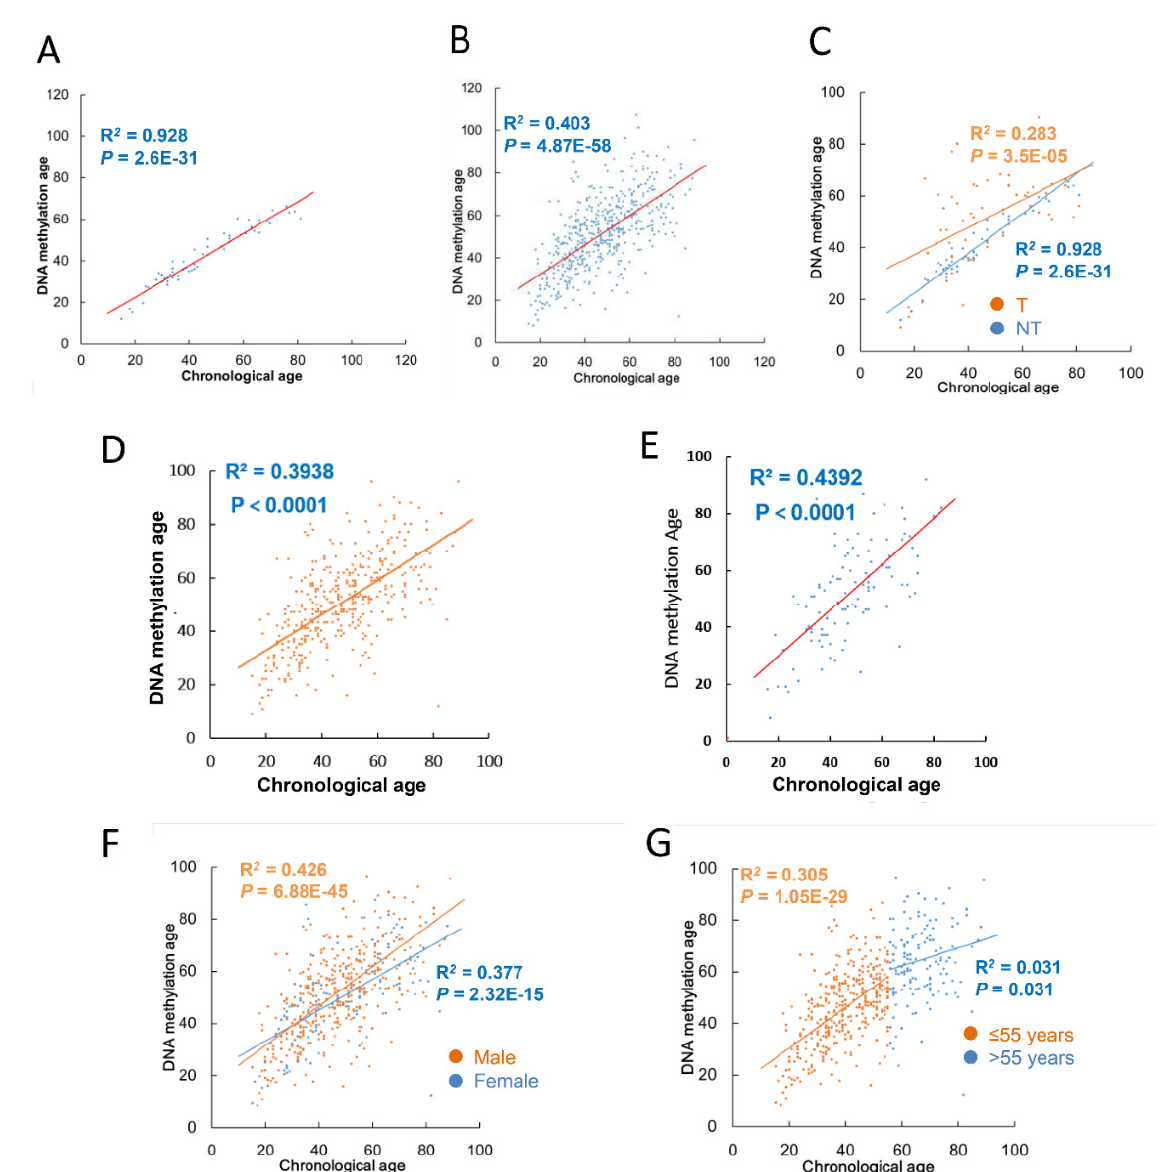
Figure 1. The correlation between DNAm and chronological age in noncancerous thyroid (NT) tissues and tumors from patients with thyroid carcinoma (TC) in the TCGA cohort. ( A ) The high correlation between DNAm and chronological age in NTs from 54 patients with TC. ( B ) The correlation between DNAm and patient chronological age in 502 TC tumors. ( C ) The correlation between DNAm and chronological age in 54 NTs and their matched TC tumors (T) from the same patients. ( D ) The correlation between DNAm and chronological age in PTC tumors. ( E ) The correlation between DNAm and chronological age in FTC tumors. ( F ) The correlation between DNAm and chronological age in TC tumors from male and female patients. ( G ) Weak correlation between DNAm and chronological age in TC tumors from patients with >55 years old.